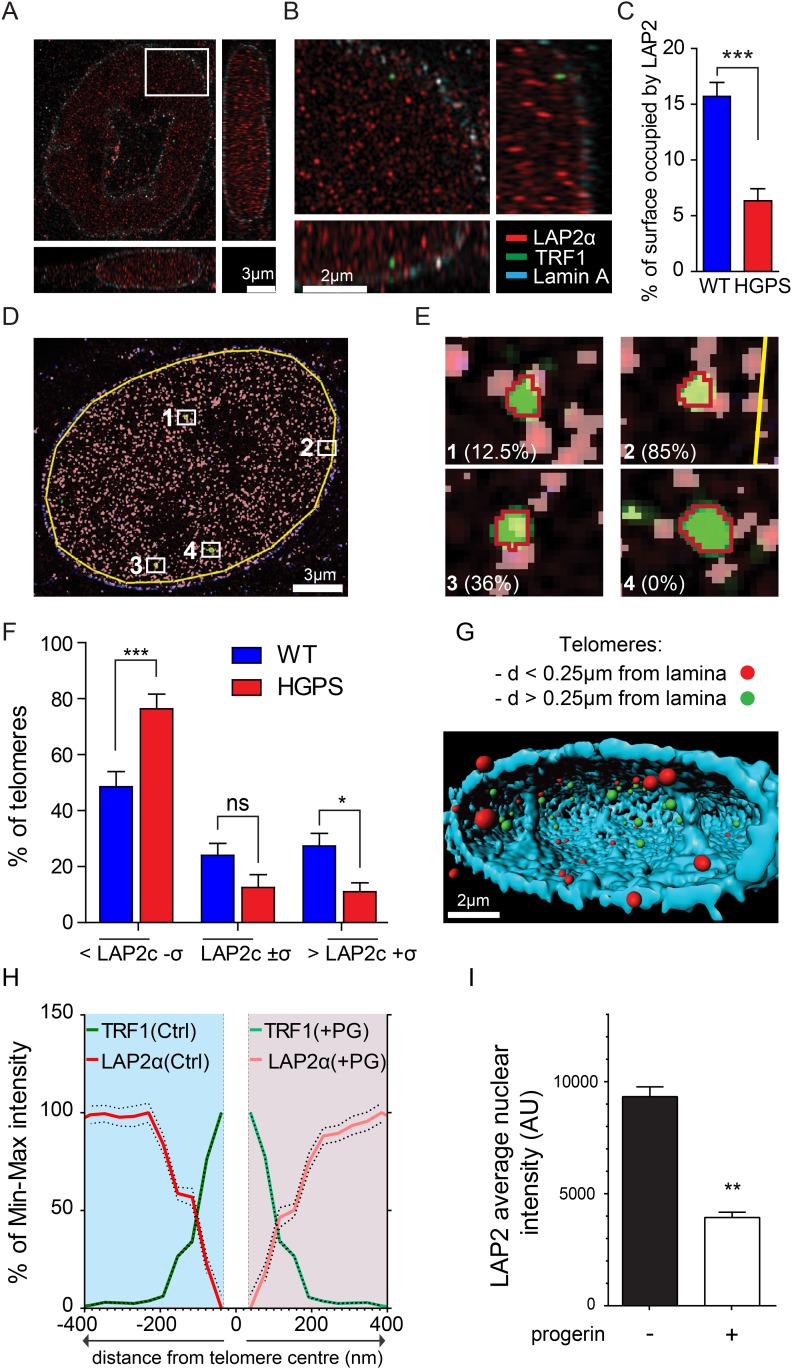
LAP2α association with telomeres, control experiments and details of analysis.(A, B) Projection of an extended section of a HGPS nucleus showing lamin A (blue), LAP2α (red) and TRF1 (green) staining. Scale bar (A): 3 μm; scale bar (B): 2 μm. (C) Average surface occupied by LAP2α in wild type and HGPS nuclei (errors bars indicate SEM, p < 0.001, n = 25, Student's t-test). (D) Processed section of a wild-type nucleus showing LAP2α (pink), TRF1 (green) and lamin A. The yellow line marks the borders of the area used to quantify the average LAP2α surface coverage per nucleus (LAP2c = 15.3% in this nucleus). Scale bar: 3 μm. (E) Higher magnification of identified telomeres objects shown in (D). The red line marks the borders of the area used to quantify the LAP2α surface coverage for each telomere. LAP2α surface coverage for each telomere is indicated in brackets: telomere 1: 12.5% category >LAP2c¯±σ, telomere 2: 85% category >LAP2c¯±σ, telomere 3: 36% category: >LAP2c¯+σ, telomere 4: 0% category: >LAP2c¯−σ. (F) Proportion of the surface of a telomere associated with LAP2α in WT or TERT+HGPS nuclei. The LAP2α/TRF1 colocalization is expressed in relation to the average surface occupied by LAP2α for each nucleus (LAP2c: average nuclear surface covered by LAP2α in one nucleus, [n = 25, *p < 0.05, ***p < 0.001, errors bars indicate SEM, two-way ANOVA with Bonferroni's post-test]). (G) 3D rendering of a wild type nucleus from super resolution imaging data. The nuclear lamina (light blue) has been rendered partially to allow visualizing the position of telomeres within the nucleus. Telomeres are represented as spheres and their proximity to the nuclear lamina is indicated as follows: within 250 nm (red) or outside 250 nm (green) of the nuclear lamina. Scale bar: 2 μm. (H) Intensity profile of LAP2α (red) near telomeres (TRF1, green) in TERT+ human fibroblasts, control (left part) or progerin expressing nuclei (right part) along a ∼400 nm axis, relative to the minimum and maximum LAP2α and TRF1 signal per nucleus. Dotted lines indicate SEM, n ≥ 38 nuclei. (I) Average LAP2α intensity in control or progerin induced TERT+ human fibroblasts (n ≥ 38, **p < 0.01, errors bars indicate SEM, Student's t-test).